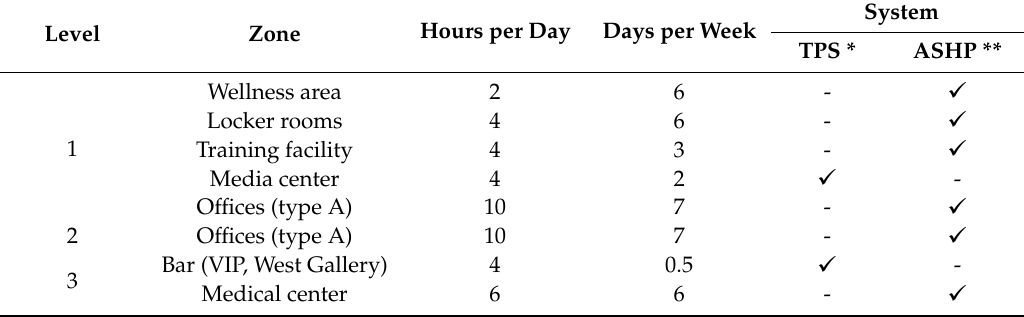
Table 7. Overview of the zones modeled on Design Builder to evaluate the energy requirements.